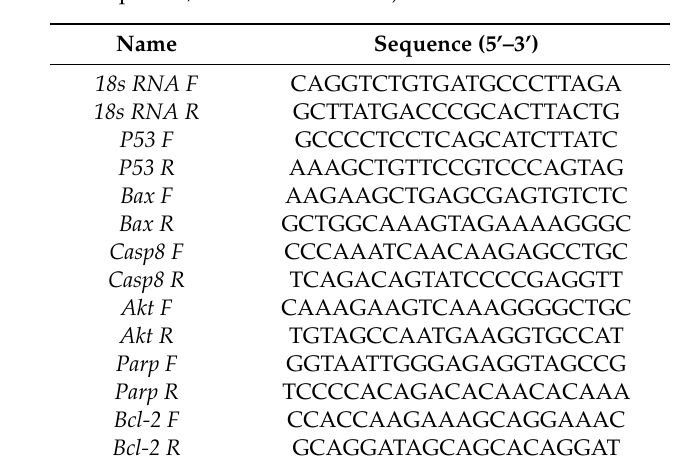
Table 1. List of primers used for the study. 18s RNA was kept as the endogenous control for the q-pcr experiment. (F = forward primer; R = Reverse